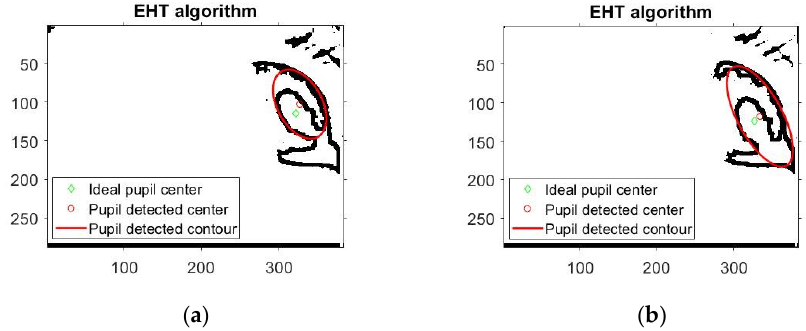
Figure 11. Typical detection errors provided by the EHT algorithm for noisy eye images.